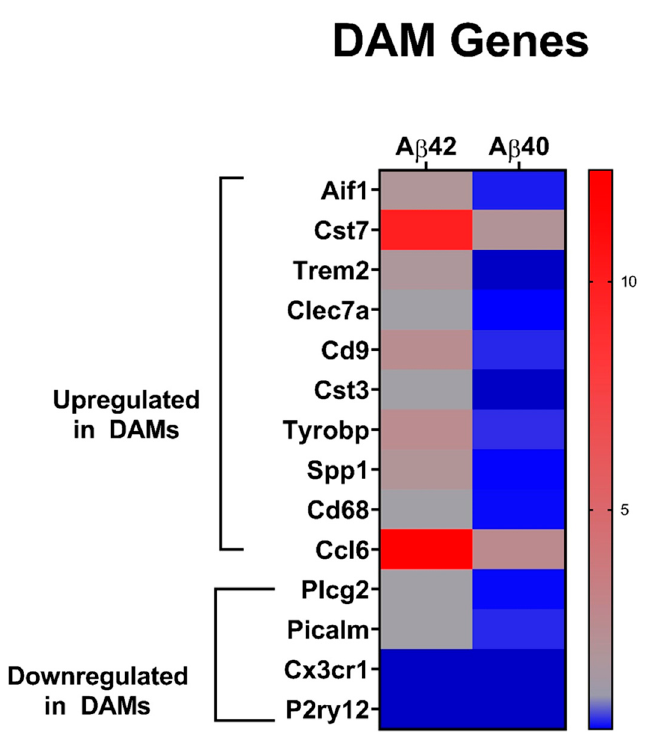
Figure 9. Relative expression of DAM genes in A β 42 and A β 40 fibril-treated primary microglia. Heat map depicting the relative expression (expression ratio compared to control microglia) of DAM-associated genes in A β 42 and A β 40 fibril-treated microglia. Red indicates significantly increased expression blue, significantly decreased expression; grey, no significant change. Color intensity is relative to the degree of change.